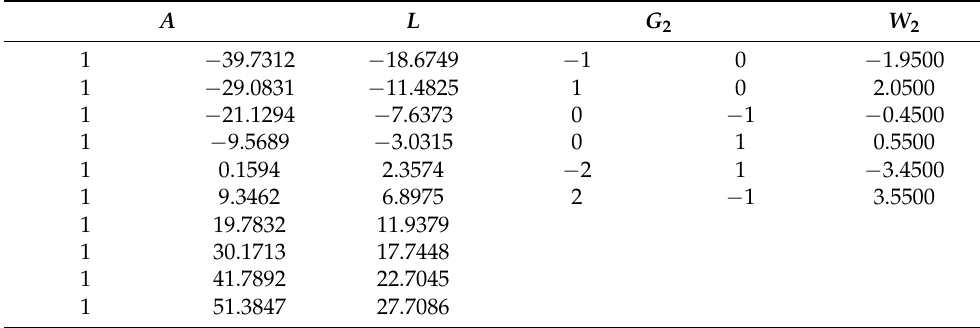
Table 2. Data set and inequality constraints of the regression model.